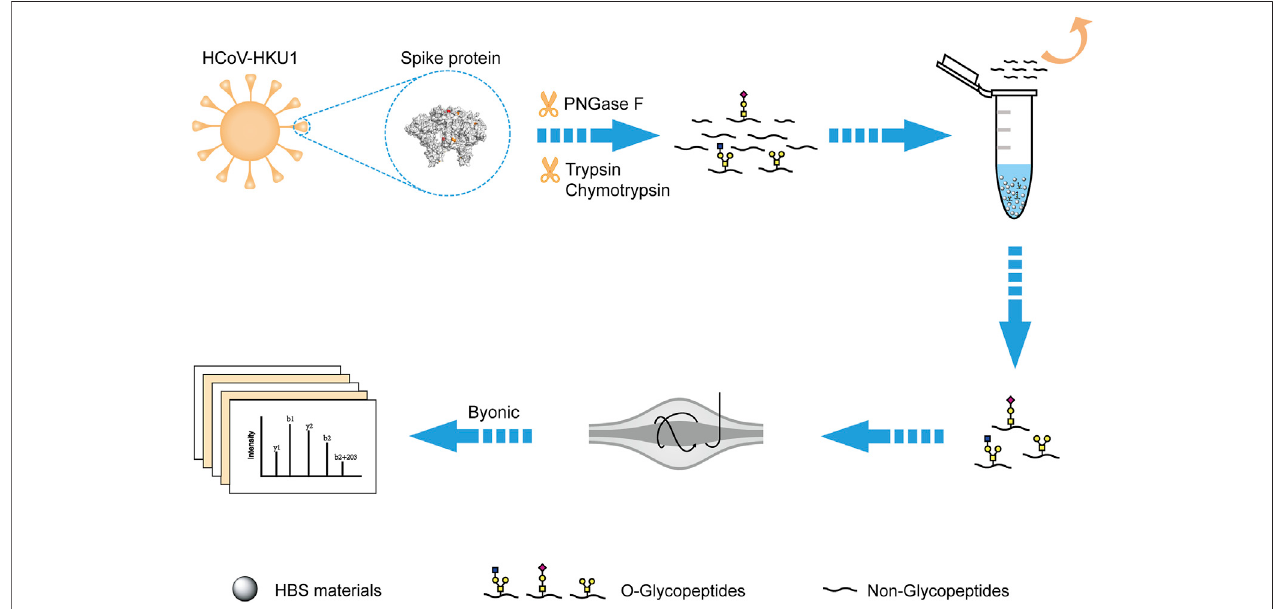
FIGURE 4 | Schematic work fl ow for deciphering the O-glycosylation of HKU1 S1 with the dual-functional hydrophilic interaction chromatography materials. The PDB code is 5I08 for the structure of HKU1 S1.